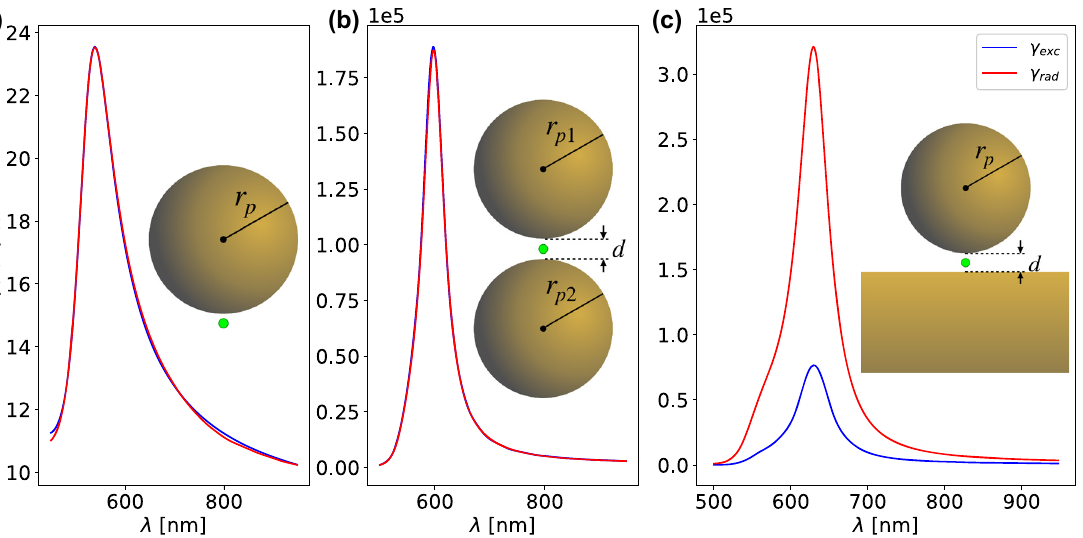
= 60 nm gold p = 60 nm gold NP p , and the rad